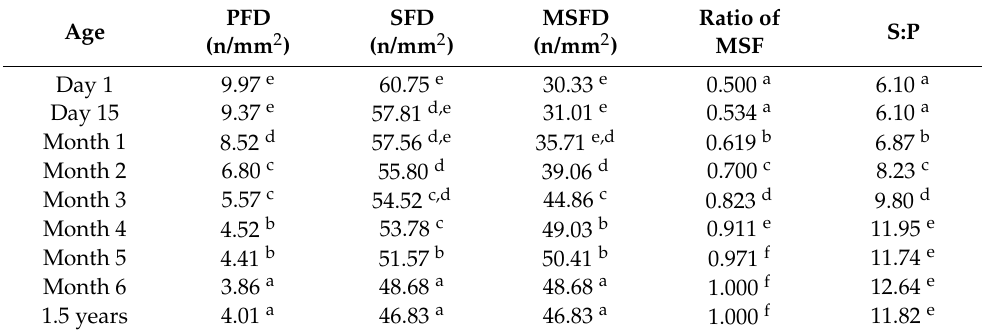
Table 5. The hair follicle trial at different time points.